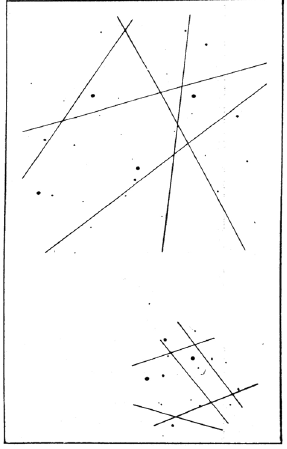
Fig. 24 John Cage, Variations I